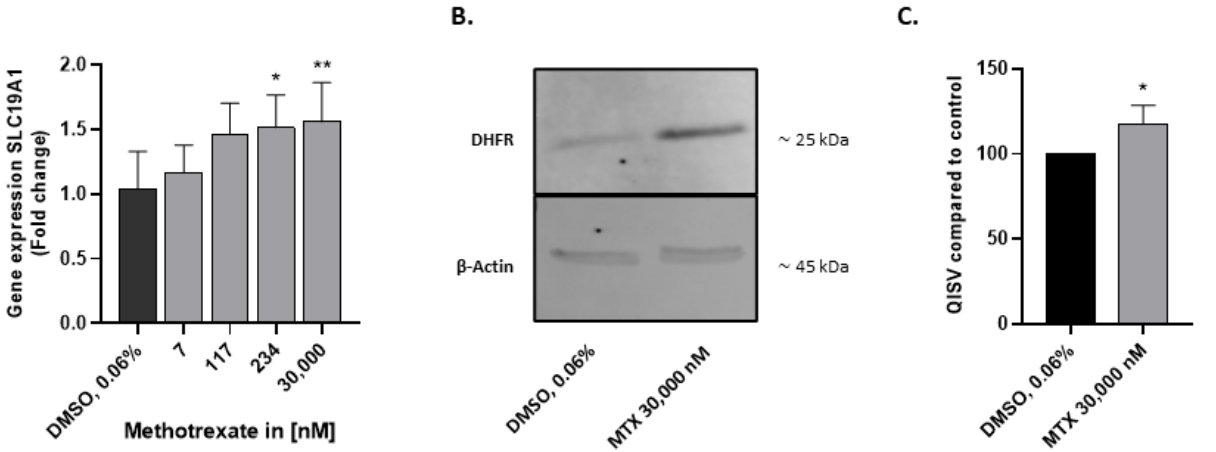
Figure 2. Expression of folate transporter SLC19A1 and DHFR in HepaRG. HepaRG were treated as previously described with or without MTX for 72 h. Gene expression of folate transporter SLC19A1, responsible for intracellular uptake of MTX, was detected using q-RT-PCR. Data are expressed as fold change, N = 3 ( A ). HepaRG were treated with 30,000 nM MTX for 7 days and processed for Western blot analysis. Anti-DHFR antibody was used to detect DHFR, β -actin was used as loading control ( B ). Semi- quantification of DHFR normalized to β -actin band intensity, N = 3 ( C ). Quantitative intensity staining value (QISV); Bar graphs represent means ± SD; statistical analysis based on one-way ANOVA ( A ) and Student’s unpaired t -test ( C ); *, p ≤ 0.05; **, p ≤ 0.01 .